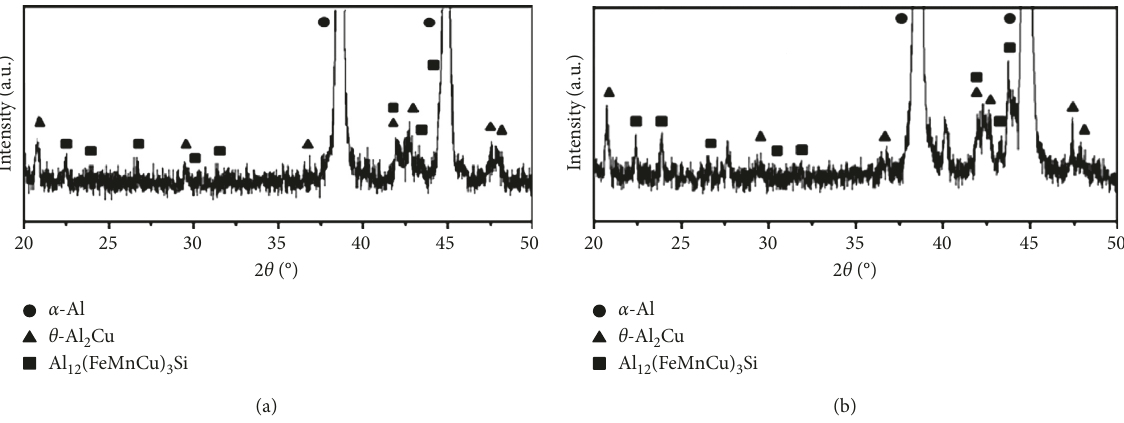
Figure 4: XRD patterns of the 90 MPa squeeze pressure in the (a) as-cast state and (b) after T6 heat